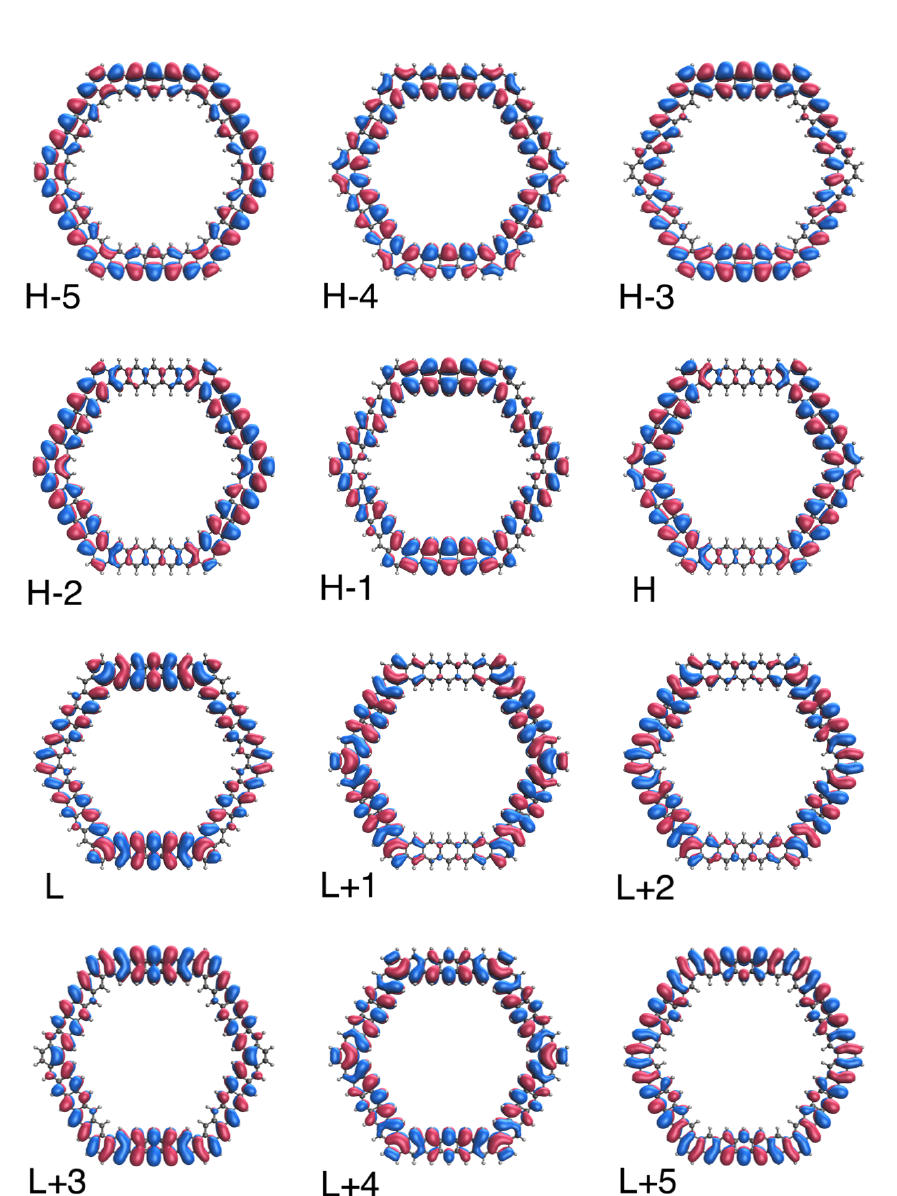
Figure 8. Real-space representation of active TAO-orbitals, such as H − 5 (1.876), H − 4 (1.826), H − 3 (1.810), H − 2 (1.810), H − 1 (1.777), H (1.777), L (0.225), L + 1 (0.225), L + 2 (0.190), L + 3 (0.189), L + 4 (0.179), and L + 5 (0.121), of ground-state 7-HGQR, obtained from spin-restricted TAO-LDA, at isovalue = 0.02 e/Å 3 . The TOONs are given in